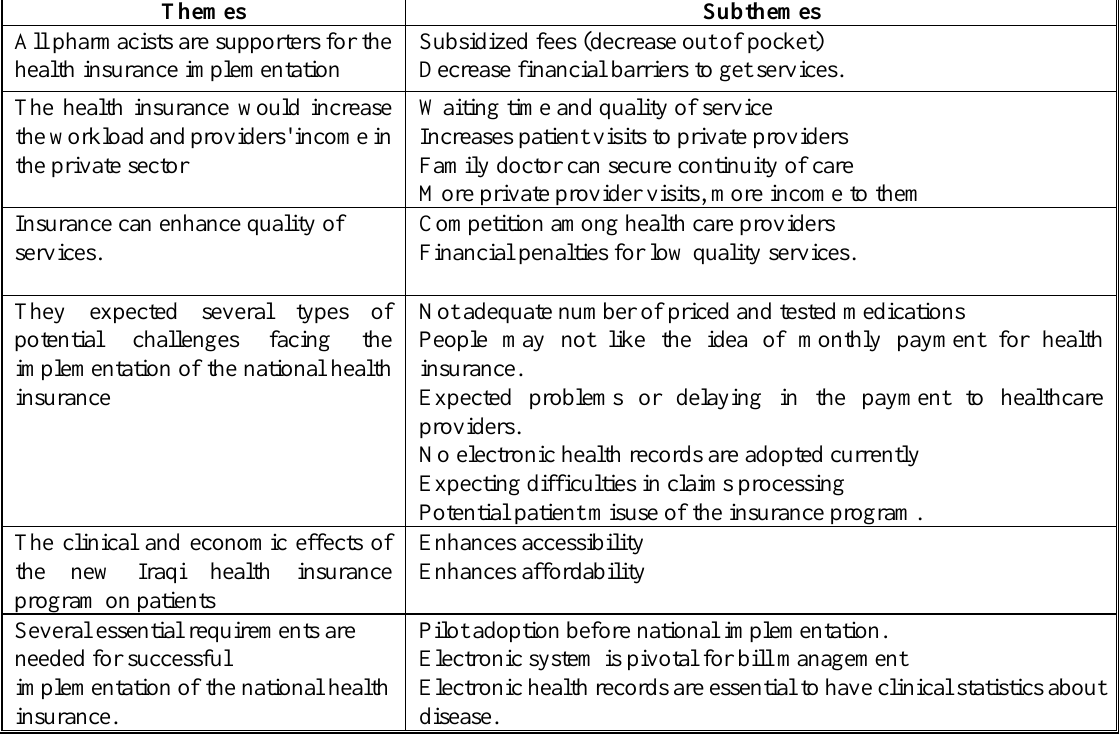
Table 2. Main themes and subthemes of pharmacist insights regarding the national health